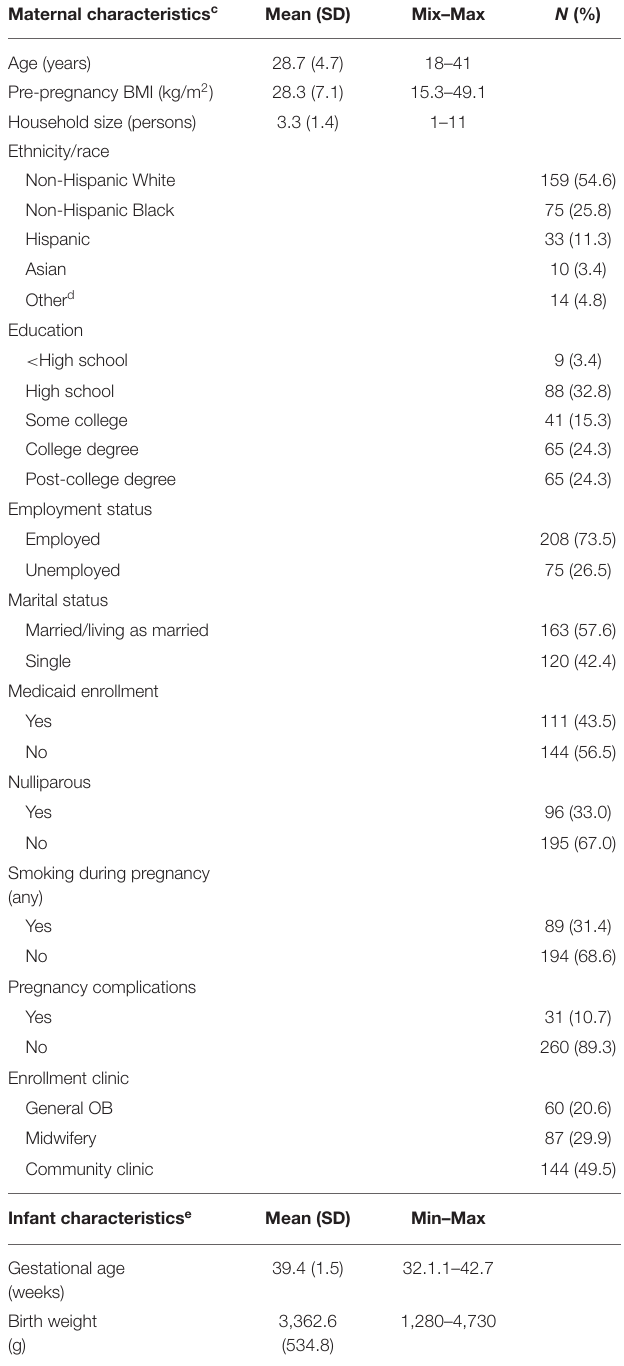
TABLE 1 | Sample descriptive data ( n = 291 a,b